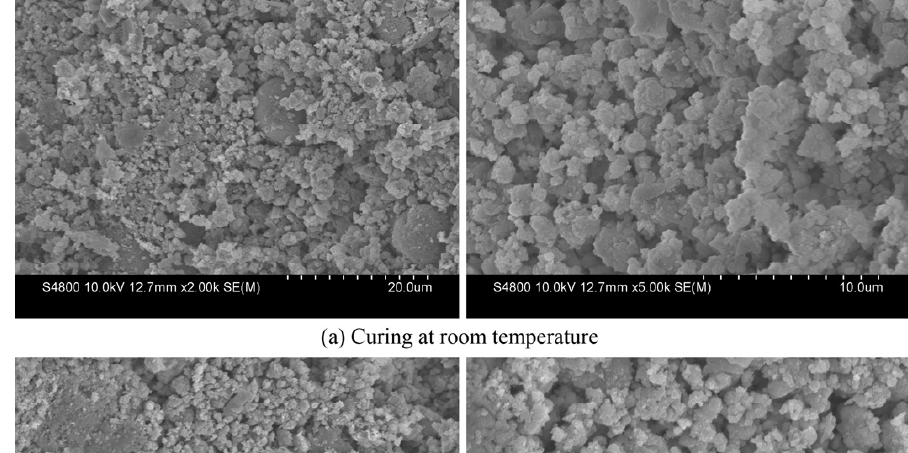
Figure 5. SEM micrographs of the RM-MK geopolymers with a 50% red mud content.